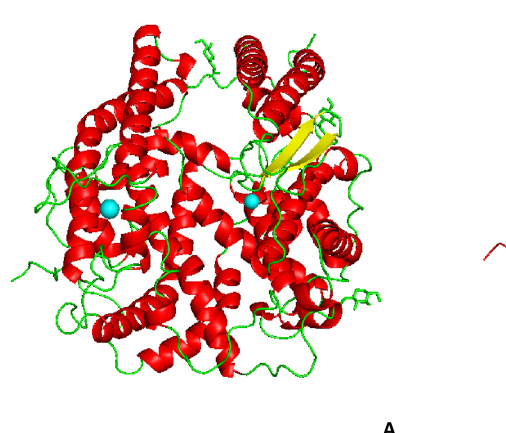
Figure 2. Molecular structure (ribbon representation) of human ACE2: ( A ) the ACE2 ectodomain, secondary structures are highlighted, in green loops, in red alpha-helices, in yellow beta-sheets, in cyan heteroatoms -Zn and C (PDB access code 1R42)l; ( B ) the ACE2-spike RBD complex, in pale cyan and pink the residues involved in the interface in the RBD and ACE2, respectively (PDB access code 6M0J).